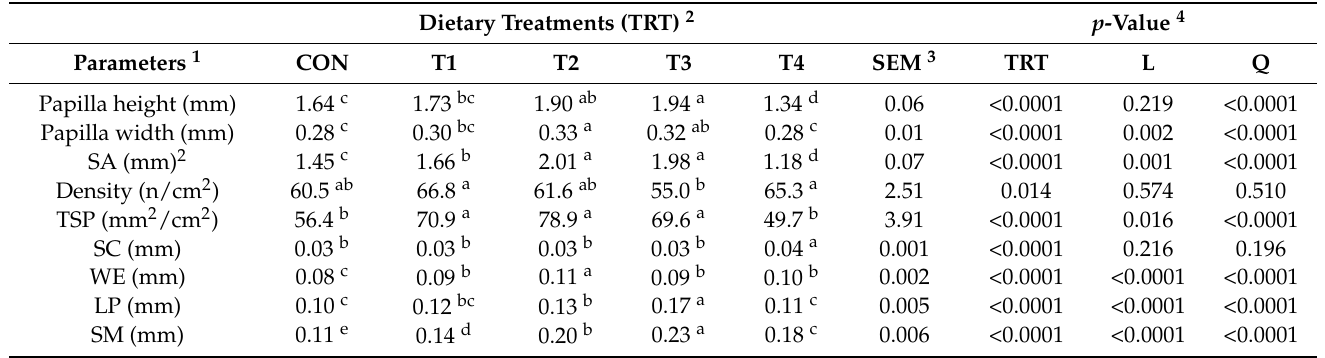
Table 6. Effect of dietary treatments on the rumen histomorphometric of growing lambs. Dietary Treatments (TRT) 2 p -Value 4